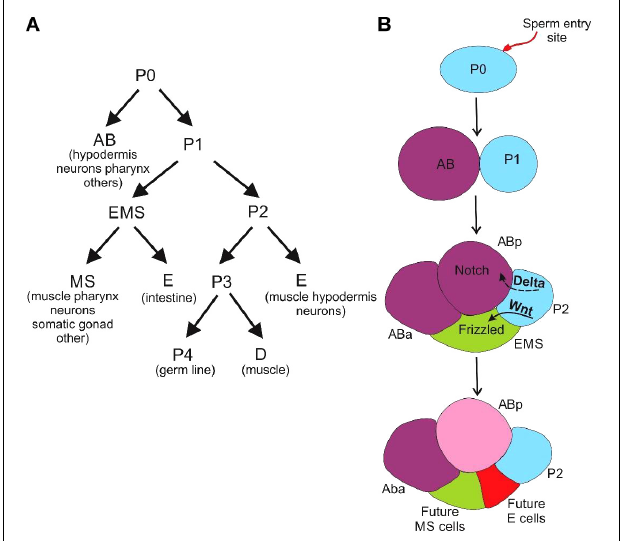
FIGURE 4 | Development of C. elegans (A) the cells derived from the asymmetric cleavage of the zygote and their future lineages (B) the AB divides longitudinally or perpendicular to the anterior-posterior axis to produce ABa and ABp cells whereas the P1 cell divides transversely to produce founder cell EMS and a posterior stem cell (P2). The effect of positional signaling between the cells with respect to P2 cell contact, at the four-celled stage via the Notch and Wnt pathways leads to specification of EMS and ABp